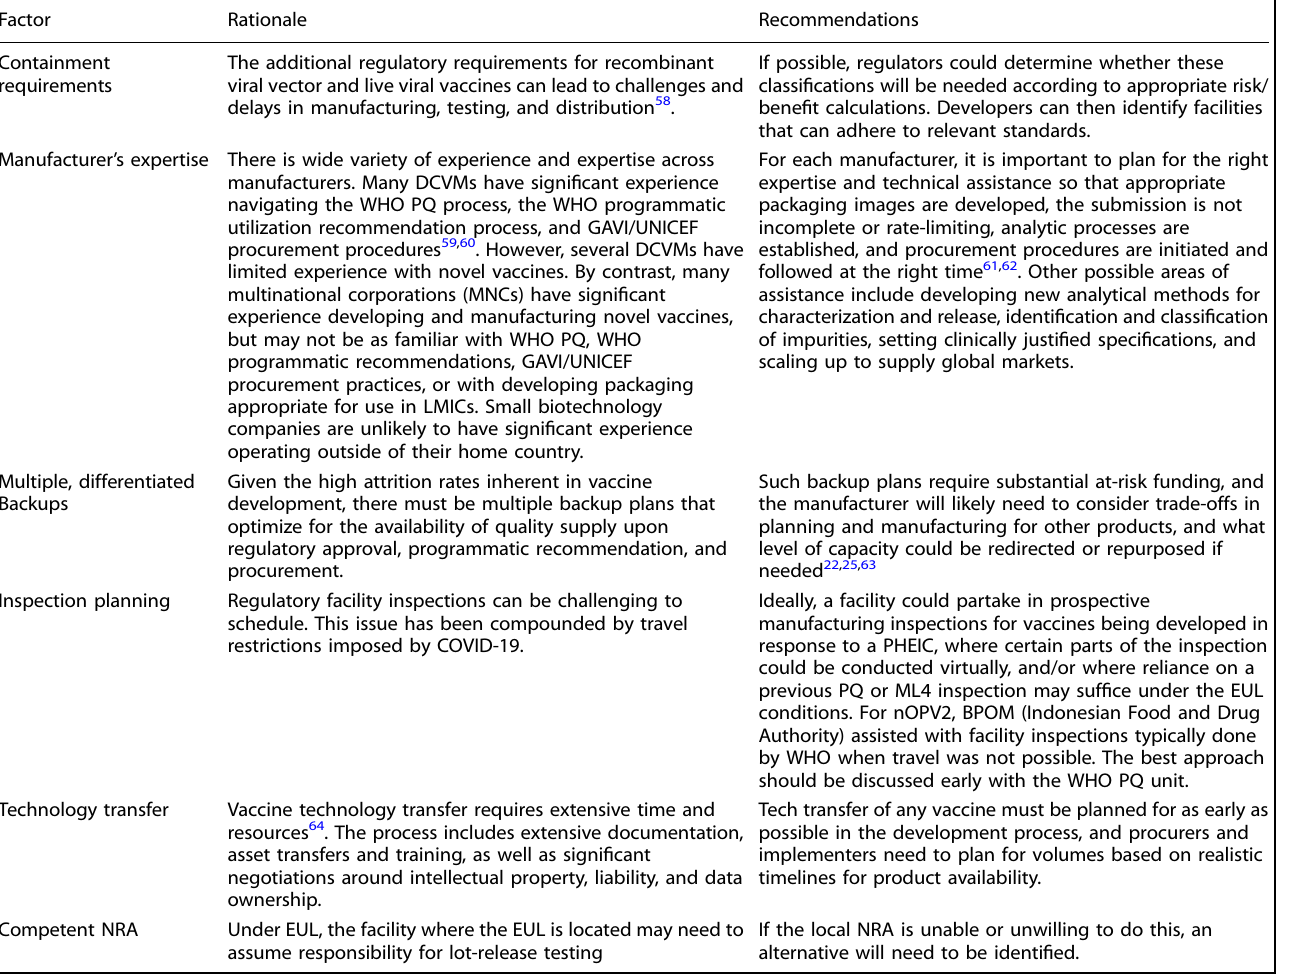
Table 2. Factors to consider in site selection and capacity